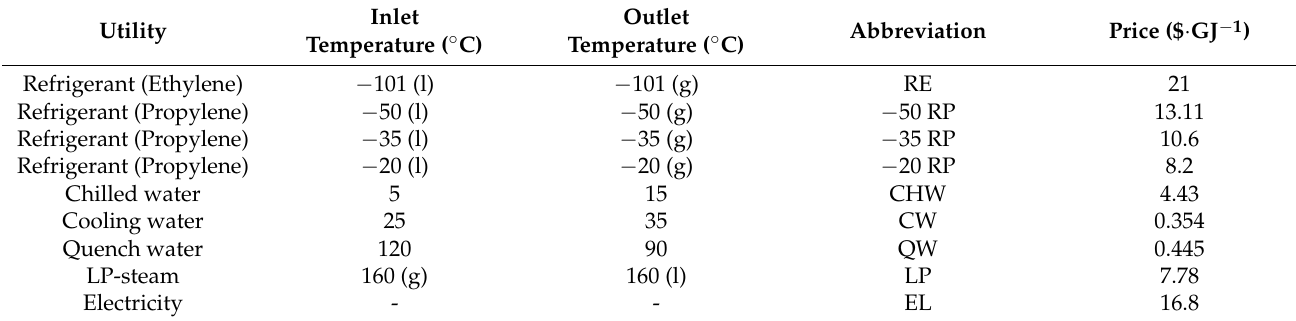
Table 3. Prices of different